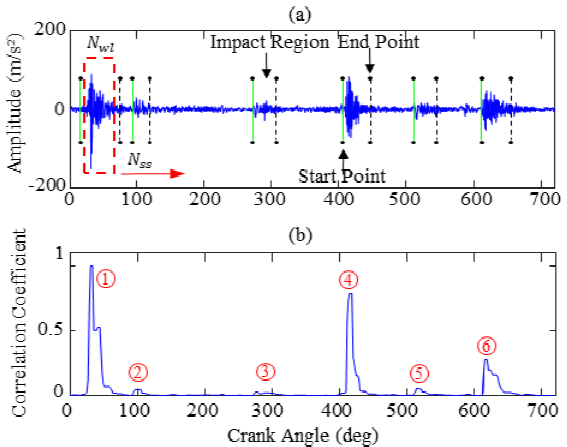
Figure 8. Adaptive correlation threshold processing: ( a ) impact location; ( b ) correlation coefficient.